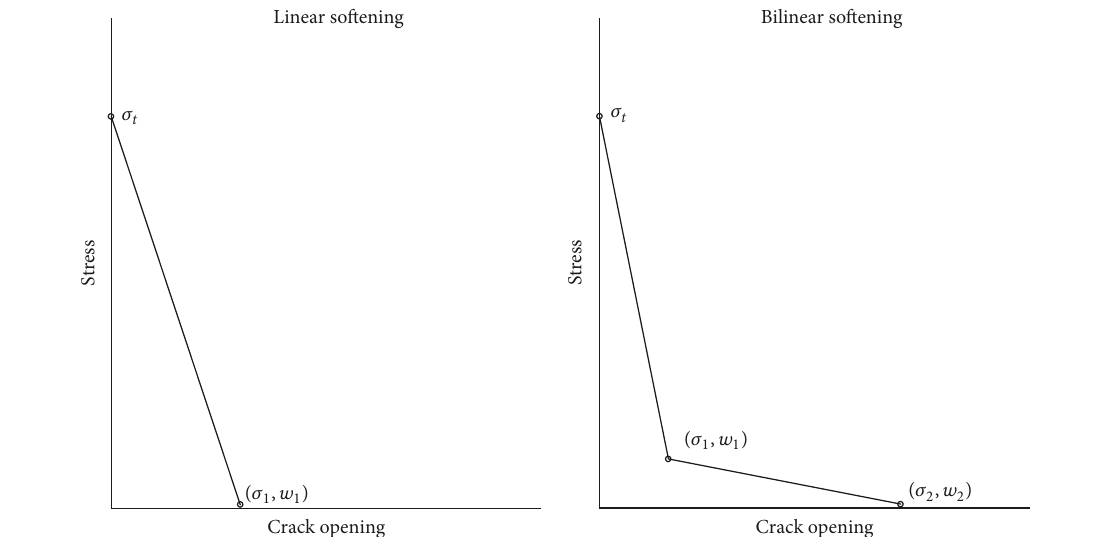
Figure 1: Schematic view of linear and bilinear strain softening.